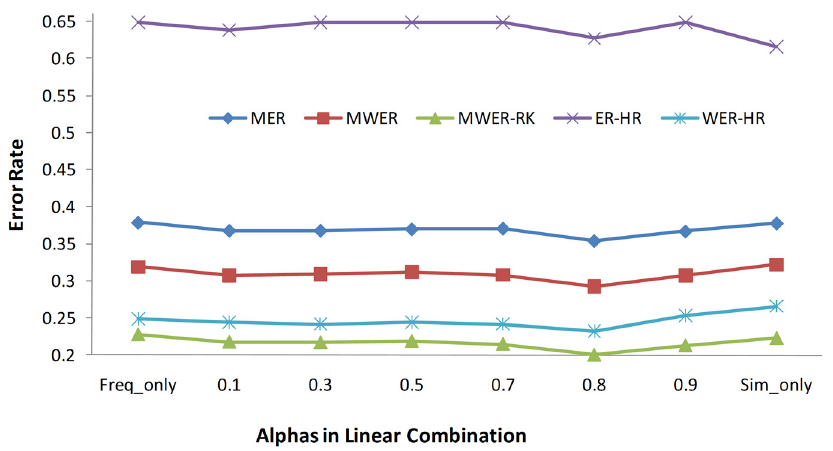
Figure 3. Performance curve with different a ’s in the linear combination. a being 0 corresponds to frequency based system and 1 corresponds to the similarity based system.